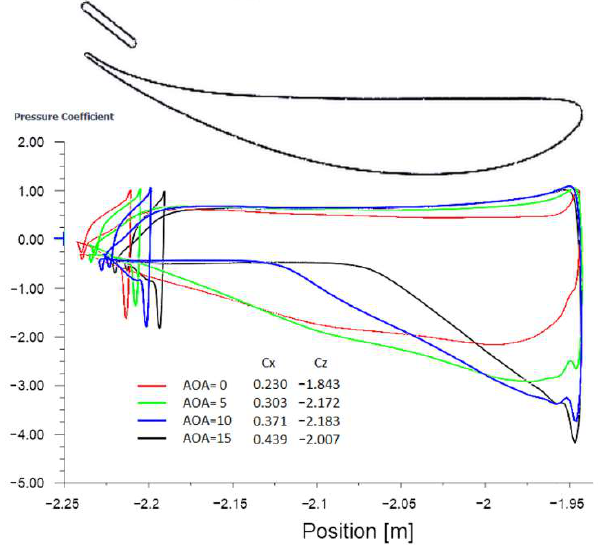
Figure 18. Pressure distributions on wing airfoil surfaces in the configuration with an inactive Gurney flap.